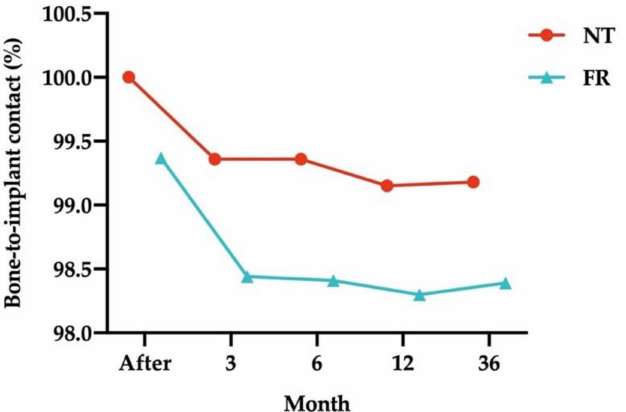
Figure 5. Mean percentages of bone-to-implant contact of the submerged dental implants opposed by natural teeth (NT) and fixed restorations (FRs) at all follow-up times. Measurements at the bottom of the graph refer to the time of implant